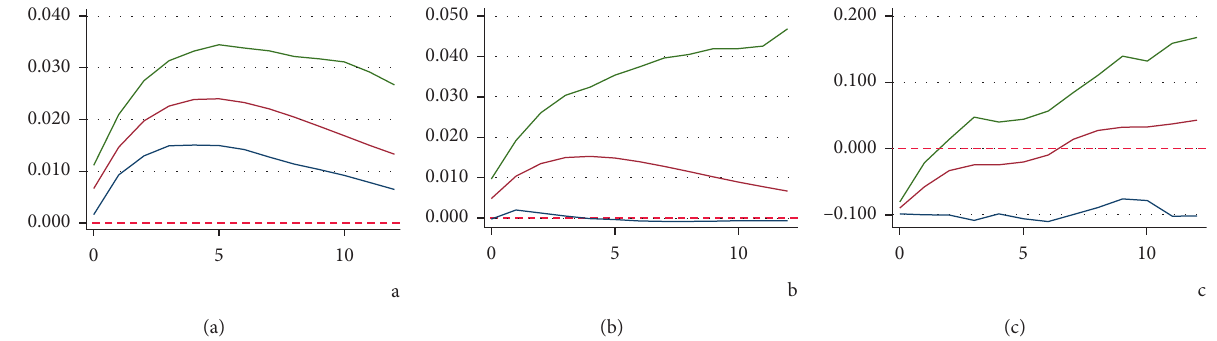
Figure 3: Impulse response results of technological innovation to environmental pollution: (a) impulse response of wastewater to TECINN, (b) impulse response of waste solid to TECINN, and (c) impulse response of exhaust gas to TECINN.